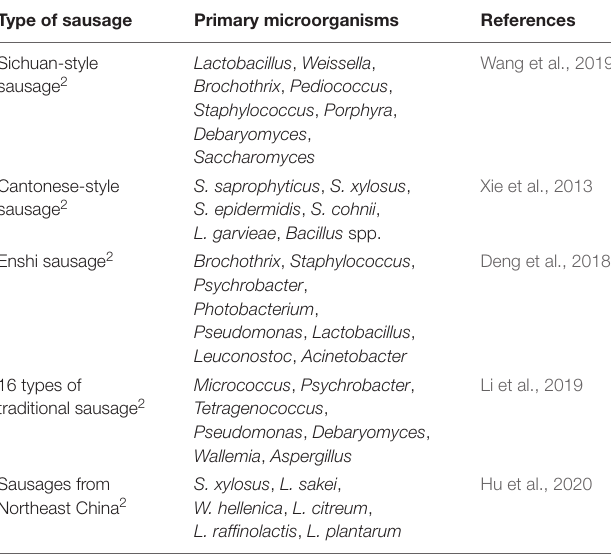
TABLE 2 | Primary microorganisms in different